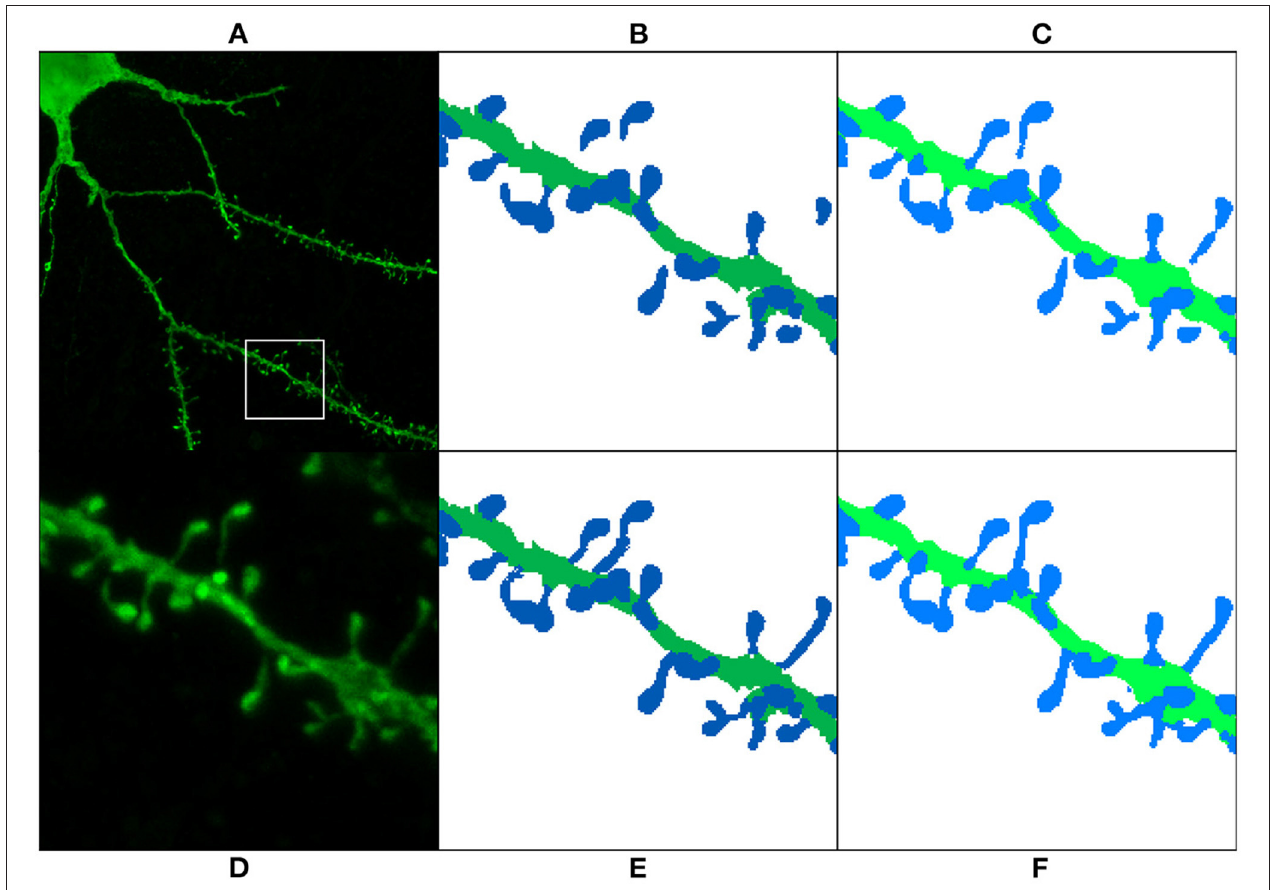
FIGURE 13 | Preprocessing comparison: (A) maximum projection of a confocal image; (D) ROI segmented in (B,C,E,F) . The GT is displayed before preprocessing (B) and after preprocessing (E) . (C,F) Show the prediction obtained with ArchM1. (C) Shows the results for the model trained with the non-preprocessed GT, whereas (F) displays those of the model trained with the preprocessed GT. We use dark colors to show the manual segmentation (GT) and bright colors for networks predictions. The segmented spines are shown in blue and the dendritic shafts in